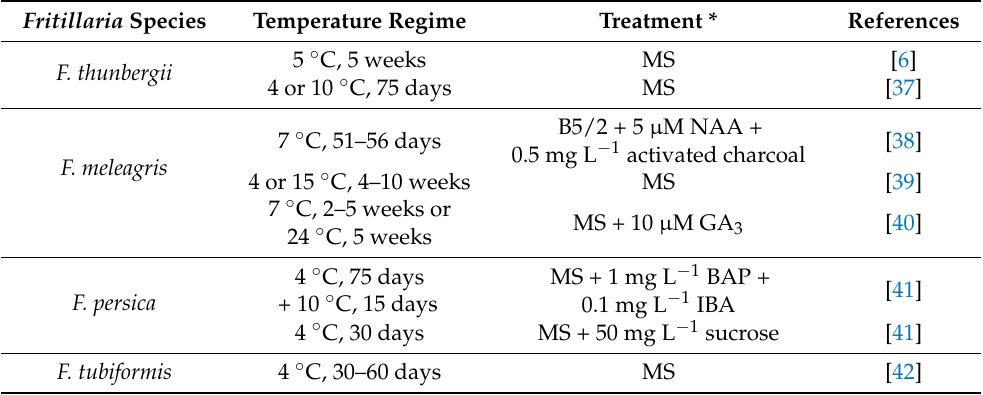
Table 1. Effect of temperature regime and nutrition media composition on bulb dormancy release in vitro in different Fritillaria